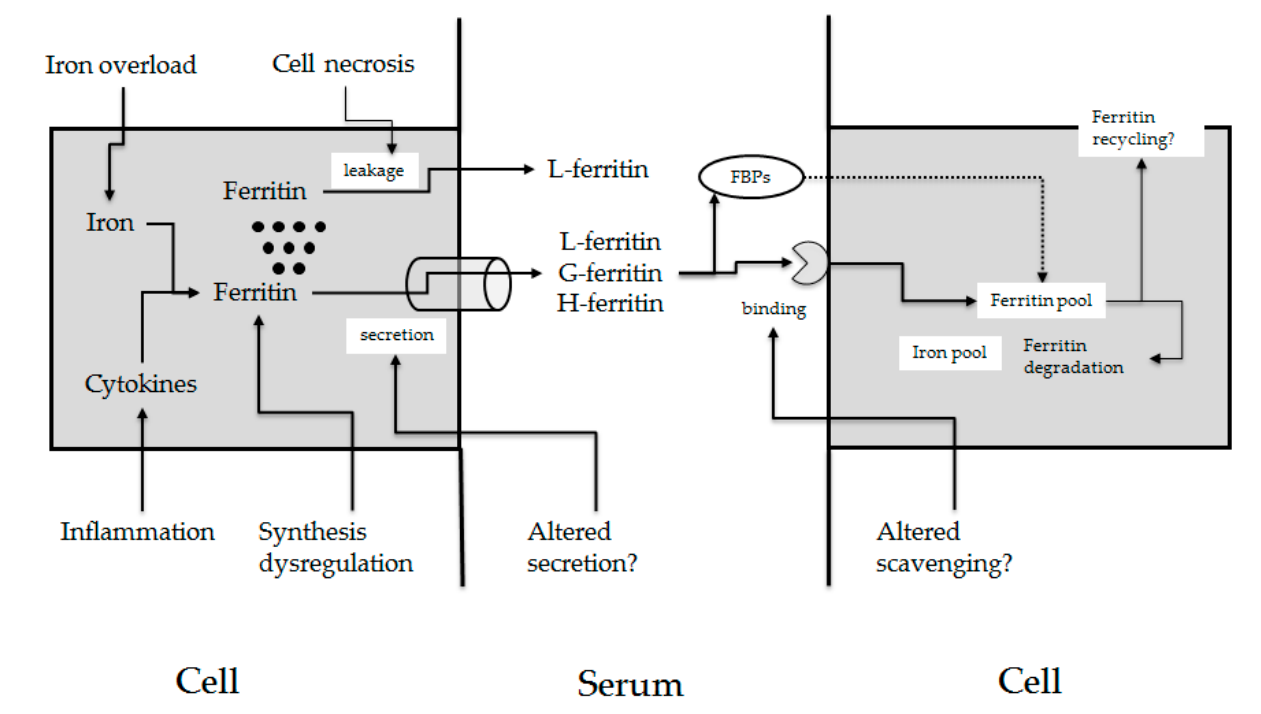
Figure 1. Physiopathology of hyperferritinemia. Iron modulates ferritin at post-transcriptional level, cytokines at transcriptional, post-transcriptional, and transductional level, and by inducing macrophage iron retention through hepcidin up-regulation. Other factors that can induce ferritin synthesis (alcohol, thyroid hormones) are not reported in the figure (see text). All these factors cause increased secretion of ferritin and hyperferritinemia. Mutations in the IRE region of FTL cause dysregulated constitutive synthesis of L-ferritin and hyperferritinemia, while mutations in the first exon of FTL cause hyperglycosylation of ferritin and altered/increased secretion or reduced ferritin clearance. Hepatocellular necrosis occurring in acute and chronic liver diseases of any cause caused increased tissue ferritin leakage by the liver. Circulating ferritin is cleared by binding to specific receptors or ferritin-binding proteins (FBP). Inside the cell, ferritin can be degraded or possibly recycled in the blood by specialized cells involved in ferritin secretion process.